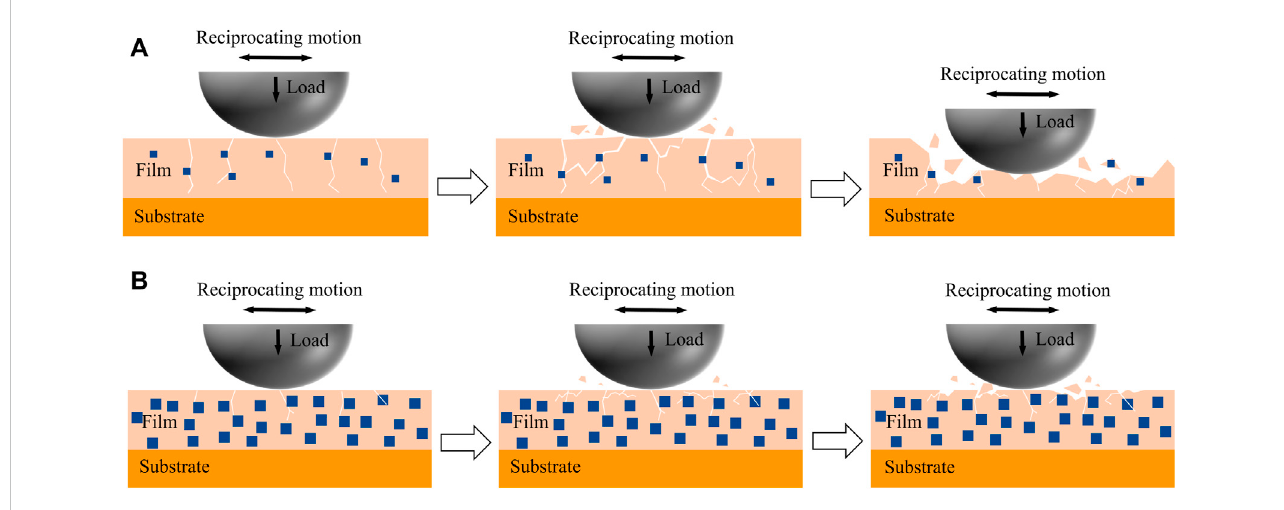
FIGURE 13 Schematic diagram about the wear mechanism of the ZrNbTiMo RHEA fi lms deposited at (A) 210 W and (B) 150